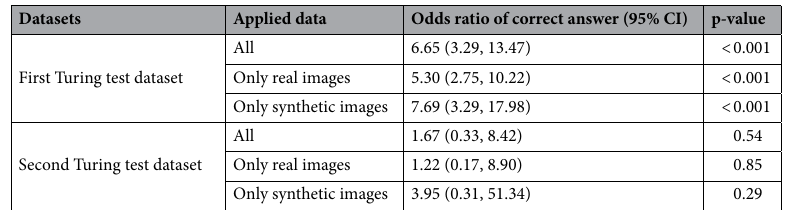
Table 3. Mixed effect logistic regression model for correcting answers in the image Turing test. Regression model: logit of correct answer ~ expert or novice + image random effect + reader random effect.